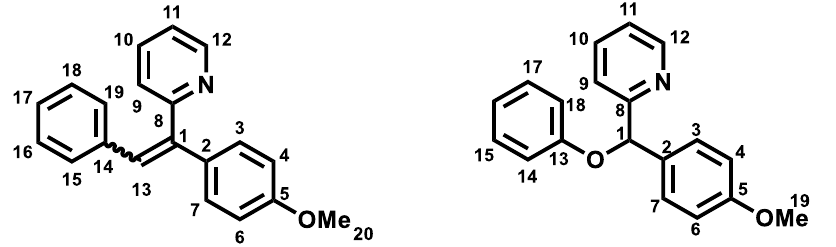
Figure 2. Convention adopted to assign signals of 1 H- and 13 C-NMR spectra. Only the chemical characterization of final DAM obtained are described herein. Intermediates are detailed as SI-1.